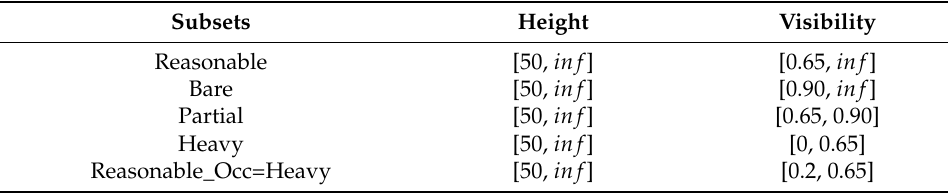
Table 1. Standards for dividing subsets of the pedestrian datasets.